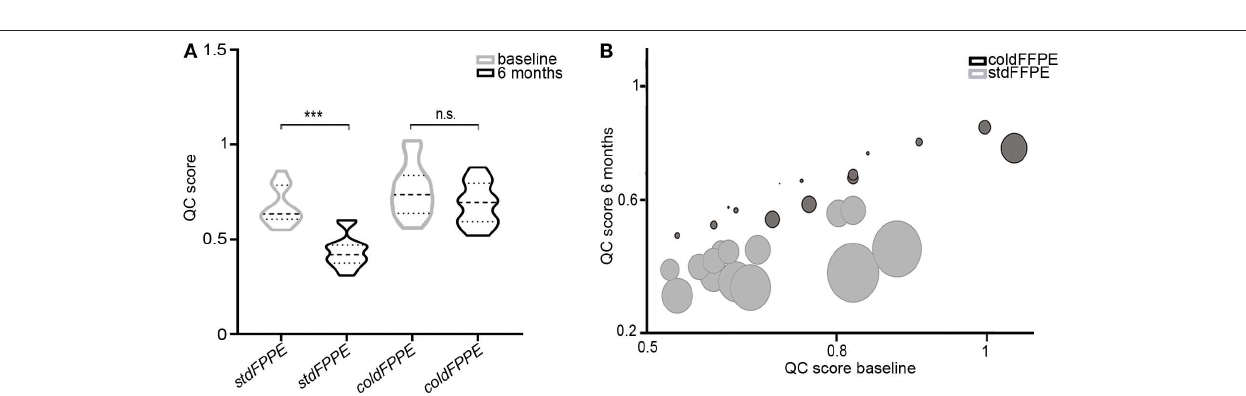
FIGURE 3 | QC score and QC score fold change in breast, colon, and lung carcinoma samples. The heatmap represents the QC score for purified DNA from stdFFPE and coldFFPE samples. The histogram shows the fold changes of the QC score in coldFFPE compared to the corresponding stdFFPE samples. The order of the samples in the heatmap is defined by the color in the histogram. All the breast stdFFPE samples shows the lowest QC score level, which is less heterogenous among the coldFFPE specimens. Nine of the first ten samples with and increased level of DNA integrity have a mammary site of origin, confirming the specific improvement for breast cancer tissue.